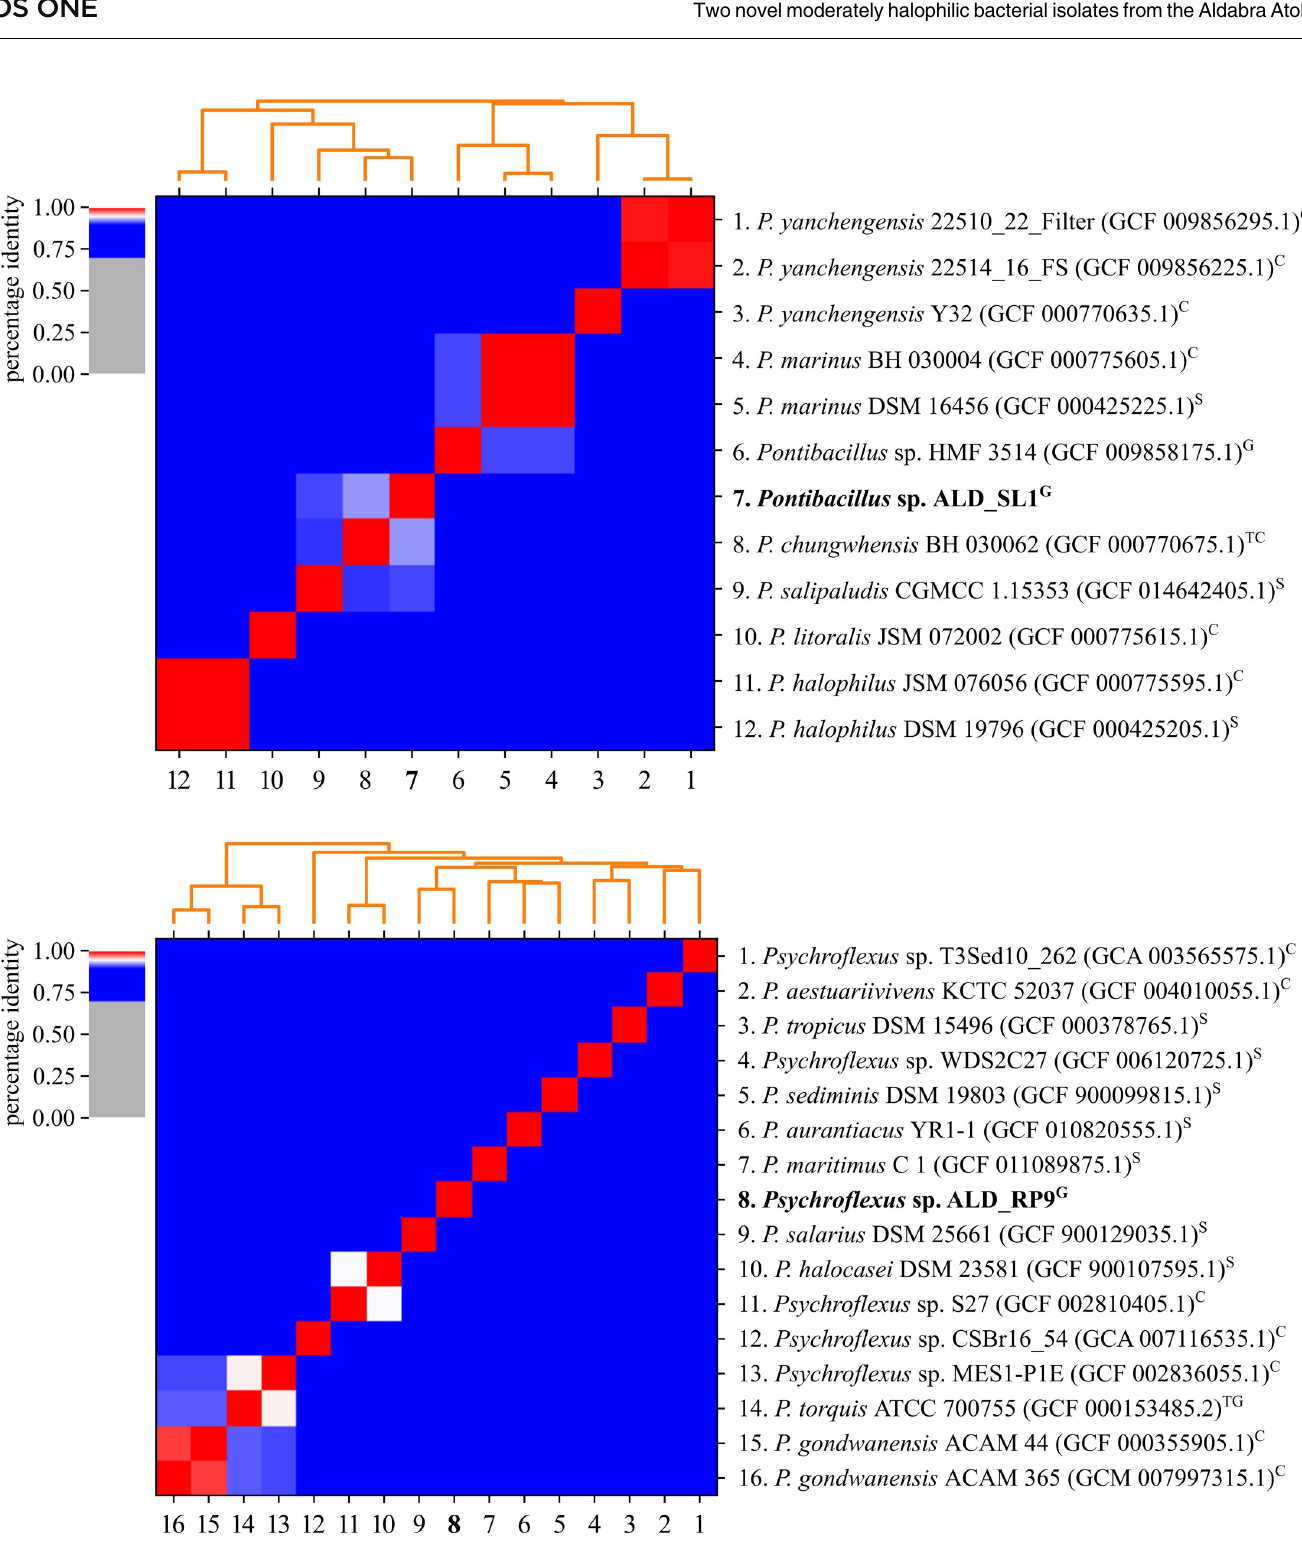
PLOS ONE | https://doi.org/10.1371/journal.pone.0256639 August 26,